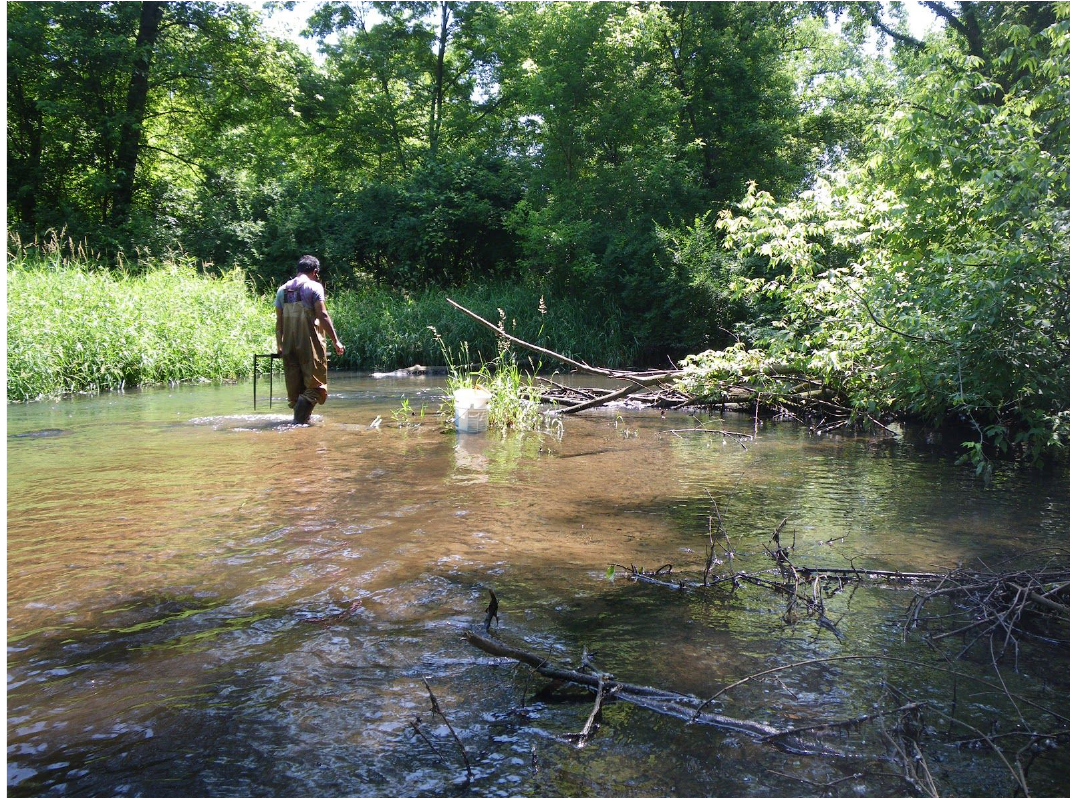
Figure A1.4. Photograph showing Sunil K. Yadav helping to measure large woody debris on June 17,